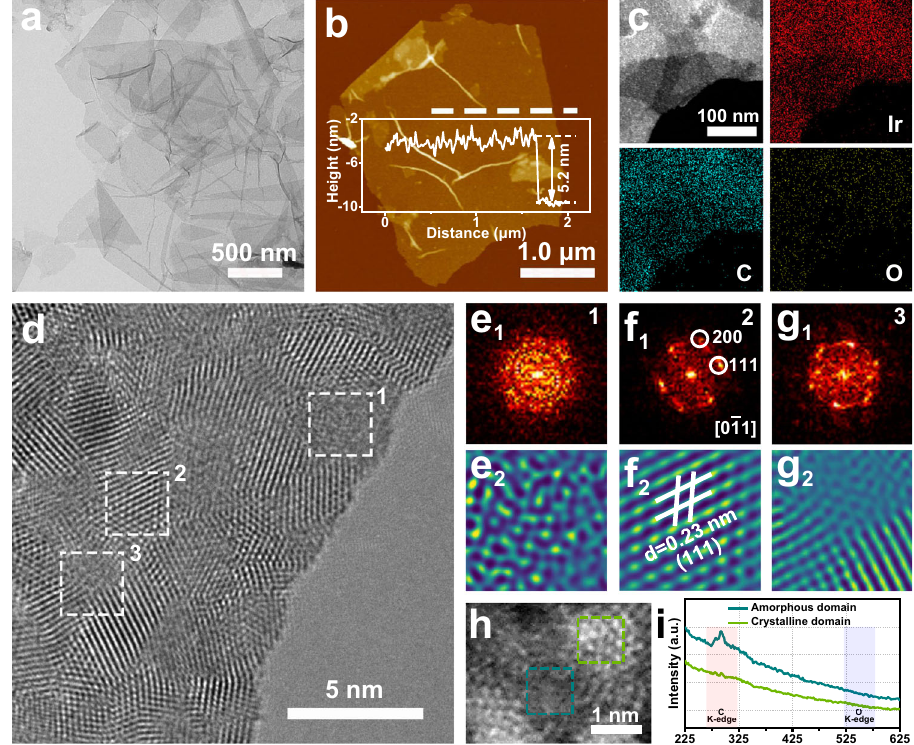
Fig. 2 Characterizations of AC-Ir NSs. a TEM image, ( b ) AFM image, ( c ) EDS elemental mapping images and ( d ) HRTEM image of AC-Ir NSs. e 1 , f 1 , g 1 FFT patterns, ( e 2 , f 2 , g 2 ) IFFT images of amorphous domain, crystalline domain and amorphous – crystalline phase boundary, respectively. h Aberration- corrected HAADF-STEM image around amorphous – crystalline phase boundary (inset: dark cyan: amorphous domain, dark green: crystalline domain.). i EELS spectroscopy of amorphous domain and crystalline domain corresponding to the selected area in ( h ), respectively. Note: AC-Ir NSs were obtained at annealing temperature of 300 o